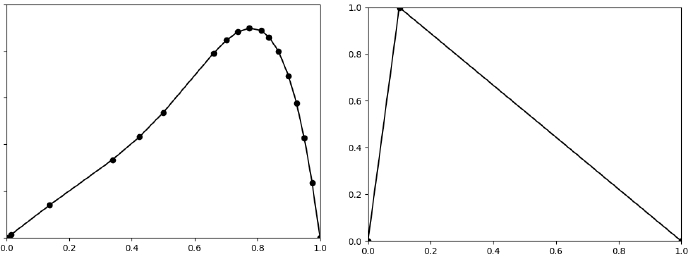
given by 18 points ( left ) and the fuzzy set A 2 2